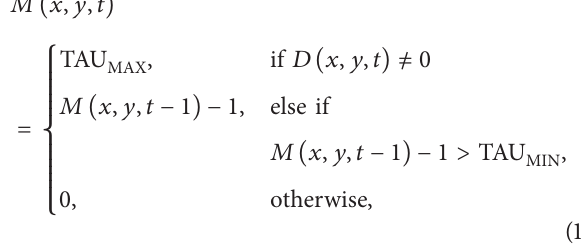
Algorithm of feature extraction from MHI using